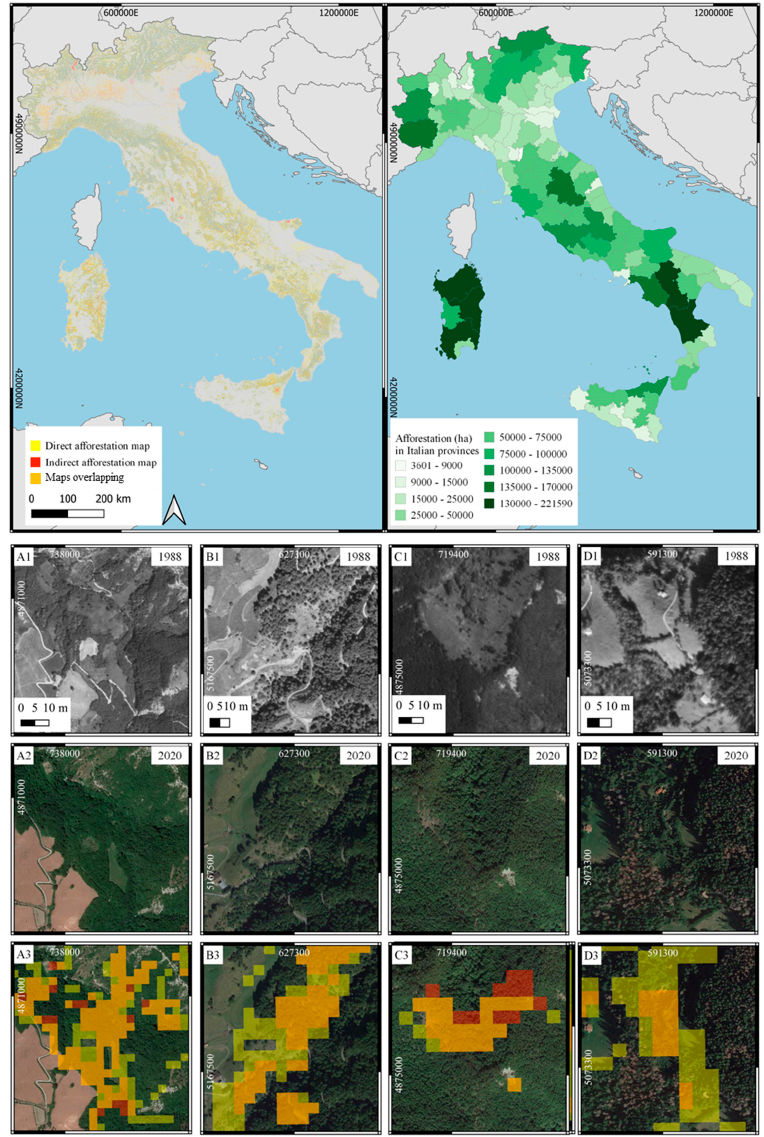
Figure 3. Afforestation maps with direct and indirect methods and map afforestation areas in Italian provinces. ( A1 – D1 , A2 – D2 ) are the aerial images referred to 1988 and 2020, whilst images ( A3 – D3 ) are the aerial images of 2020 with the predicted maps. The areas classified as afforestation by both maps are shown in orange, while the areas classified as afforestation by direct and indirect maps are shown in yellow and red, respectively. Top-right, the province (NUT3) a ff orestation area according to the direct map.